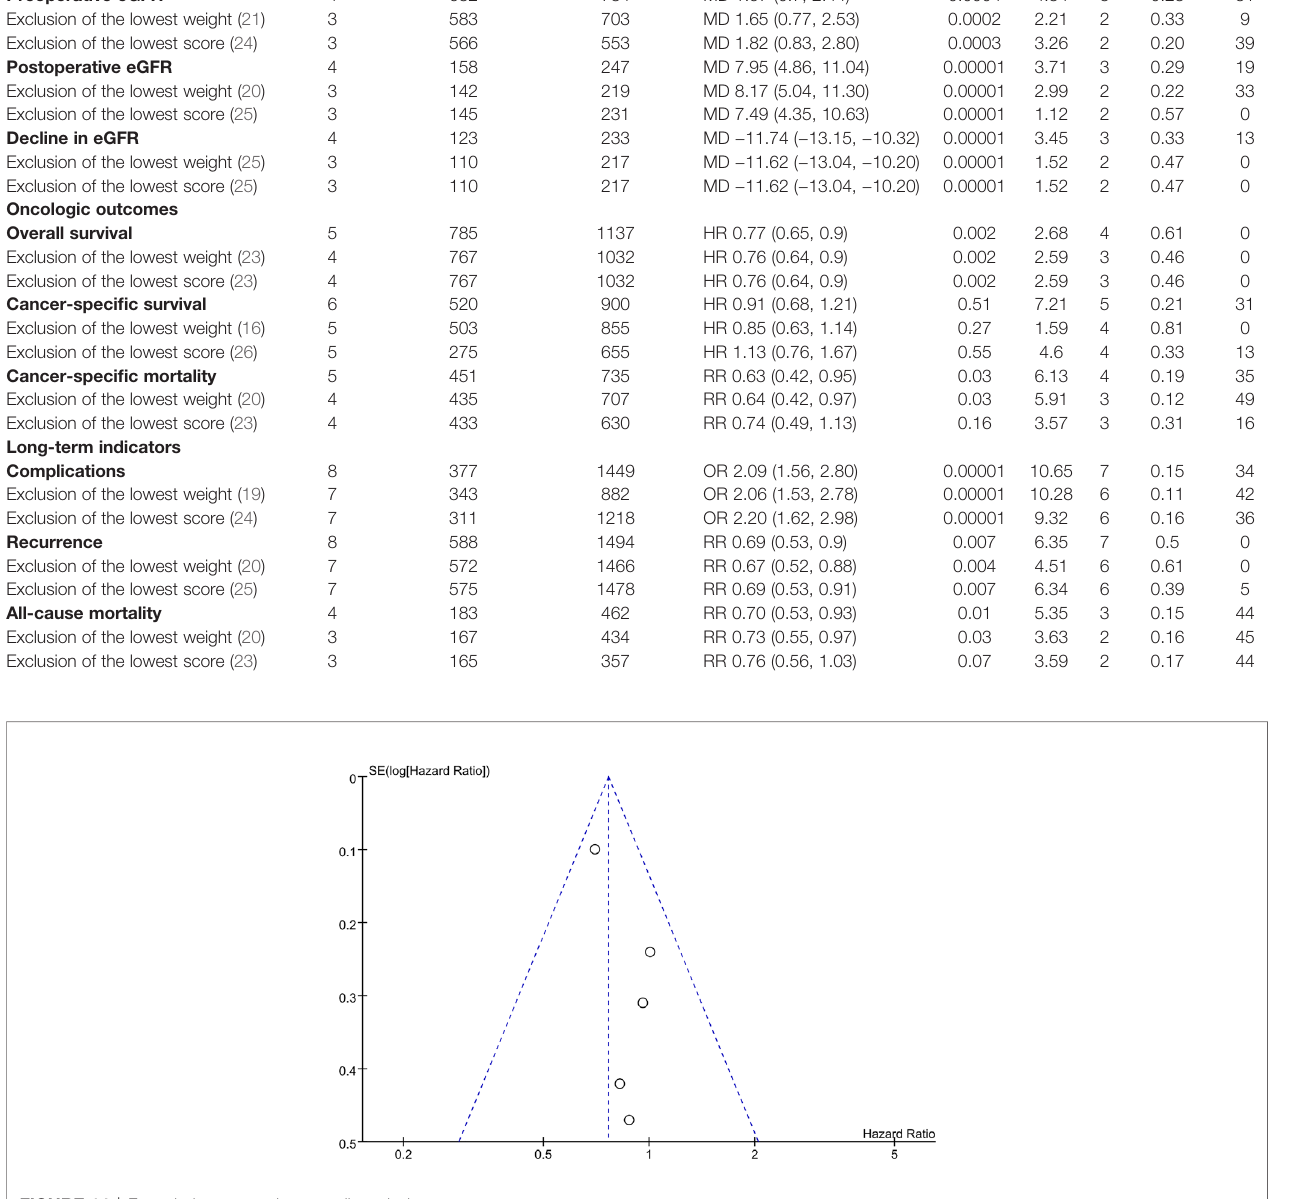
FIGURE 14 | Funnel plot concerning overall survival.